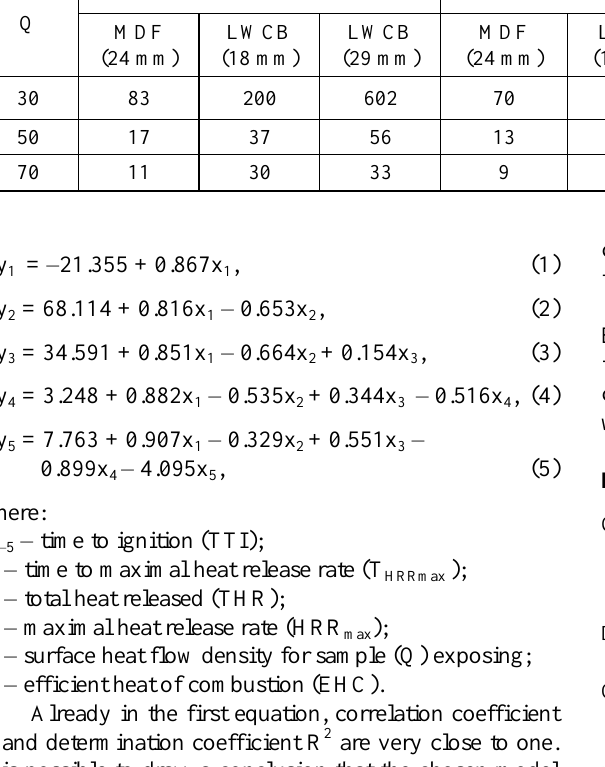
Table 4. Actual and predictable TTI values